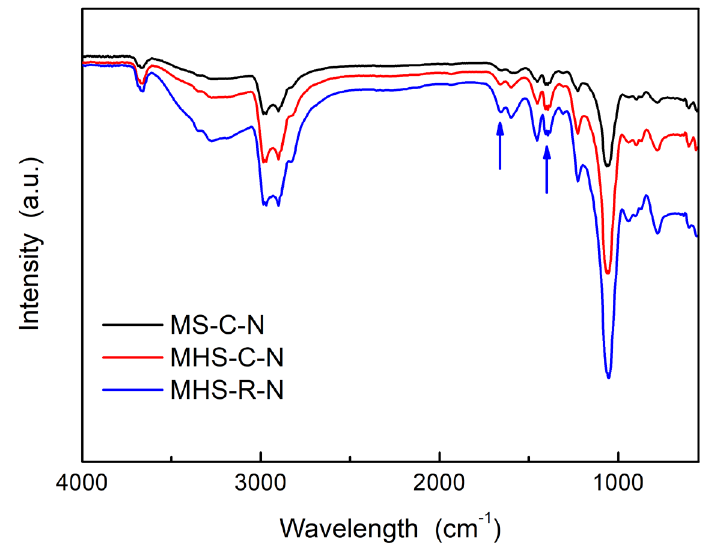
Figure 7. FT-IR spectra of mesoporous silica and mesoporous hollow silica nanomaterials after formaldehyde adsorption. formaldehyde